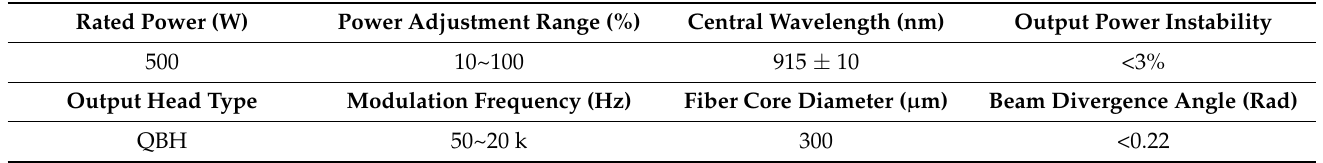
Table 3. List of key technical parameters of the